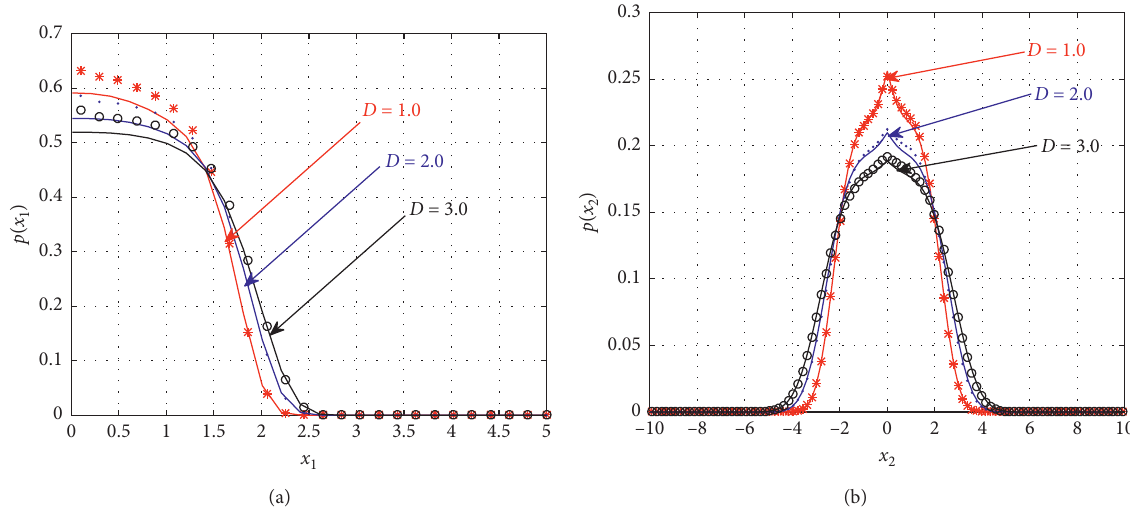
Figure 12: Stationary PDFs as r � 0 . 97: (a) displacement x